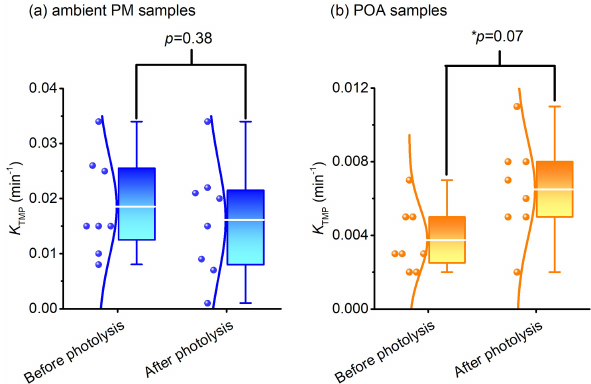
Figure 4. Changes in the triplet-state generation: (a) ambient PM and (b) POA. The lines from bottom to top in the box plots show the minimum, first quartile, the average value (white lines), third quartile, and maximum, respectively. The p value is the probabil- ity that two sets of data have the same level (two-tailed test). ∗ A significant difference is present at the 0.1